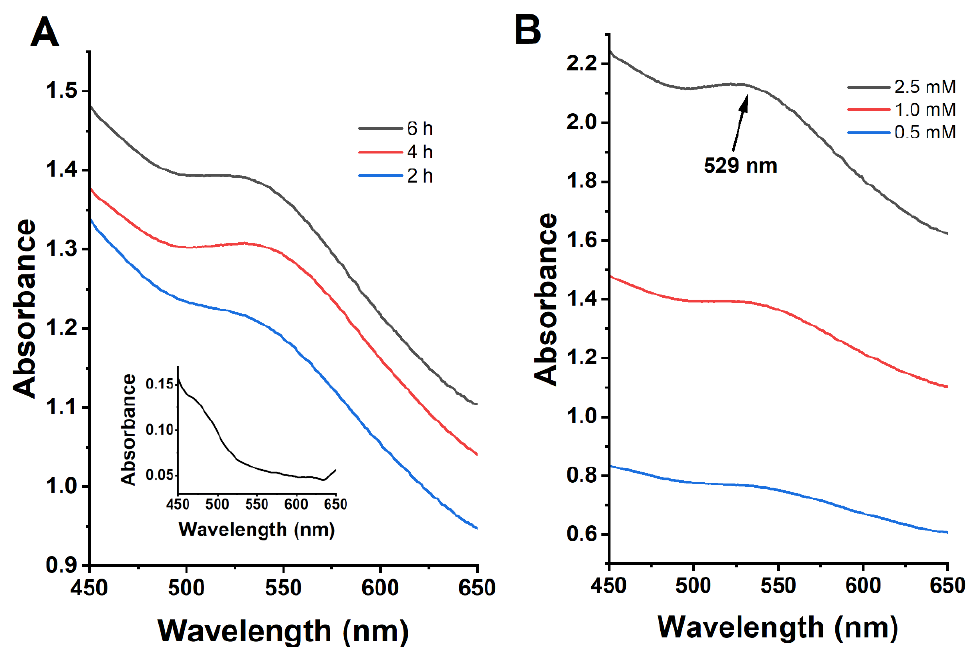
Figure 2. UV-Vis spectra of the synthesized Au NPs. ( A ) different incubation times during the green synthesis process (1.0 mM); insert: 0 h incubation (i.e., mixture of extract and HAuCl 4 in DI water). ( B ) different concentrations of synthesized Au NPs (6-h incubation).